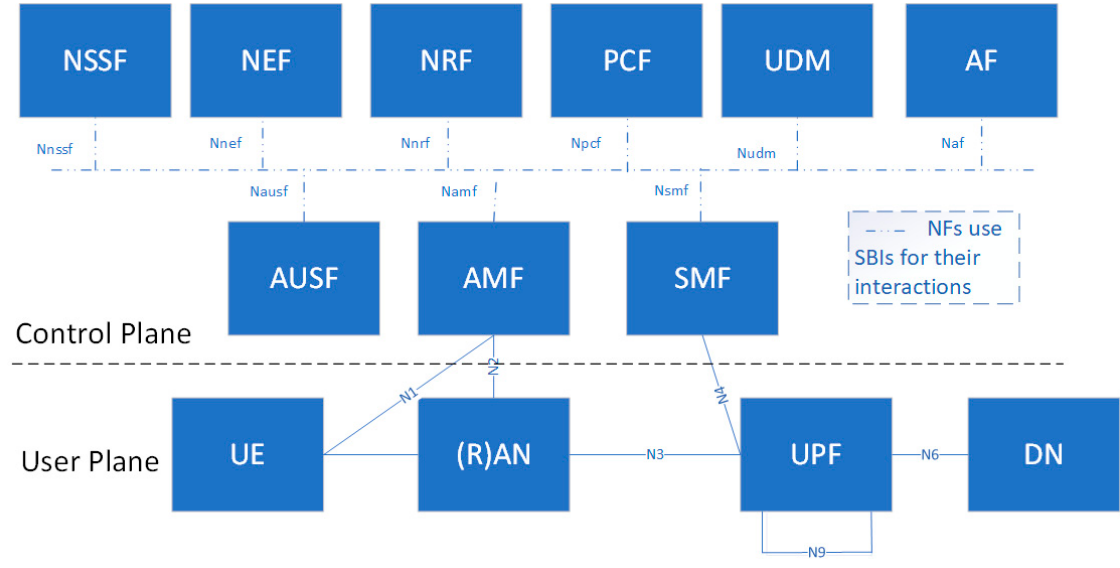
Figure 2. Service-based representation of the 5G non-roaming system architecture [34].